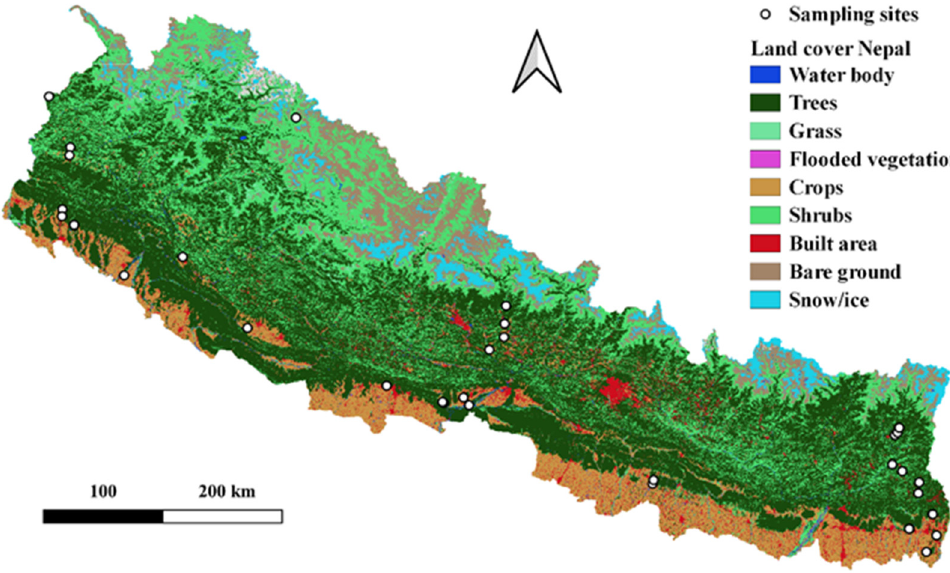
Figure 1. Land cover map of Nepal showing sampling sites.